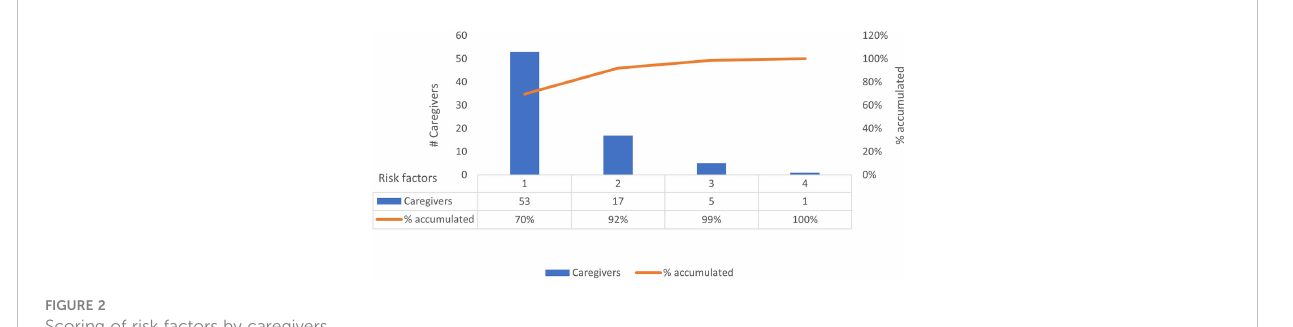
FIGURE 2 Scoring of risk factors by